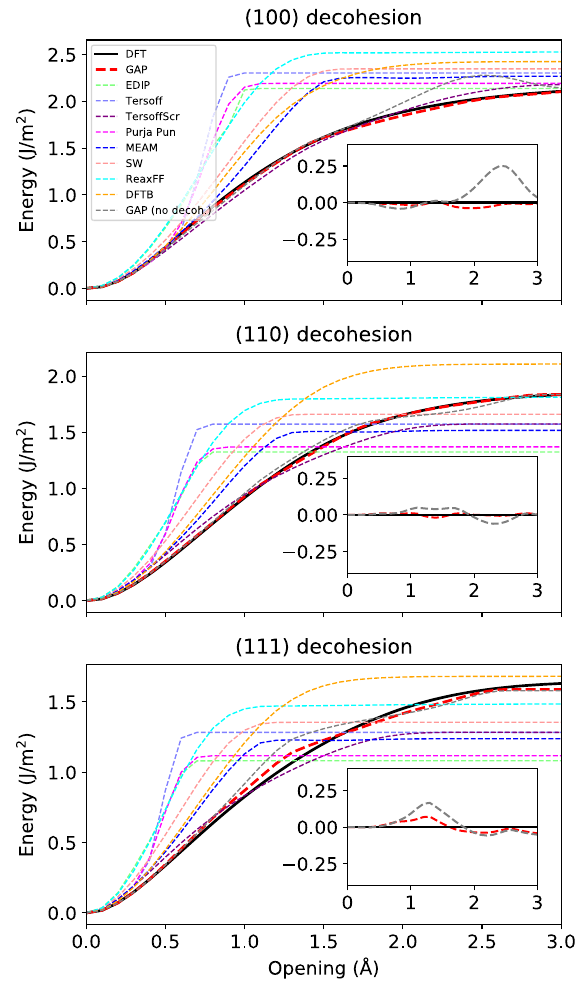
FIG. 11. Decohesion energy of diamond-structure silicon along various directions (labeled according to the orientation of the opening surface). Insets (same axes as the main plot) show errors with respect to the DFT for the current GAP (red) as well as for a previous version of the GAP (gray) with a fitting database that does not include any configurations along the separation path (or high-energy crystal-lattice structures) but only final fully sepa- rated surfaces.